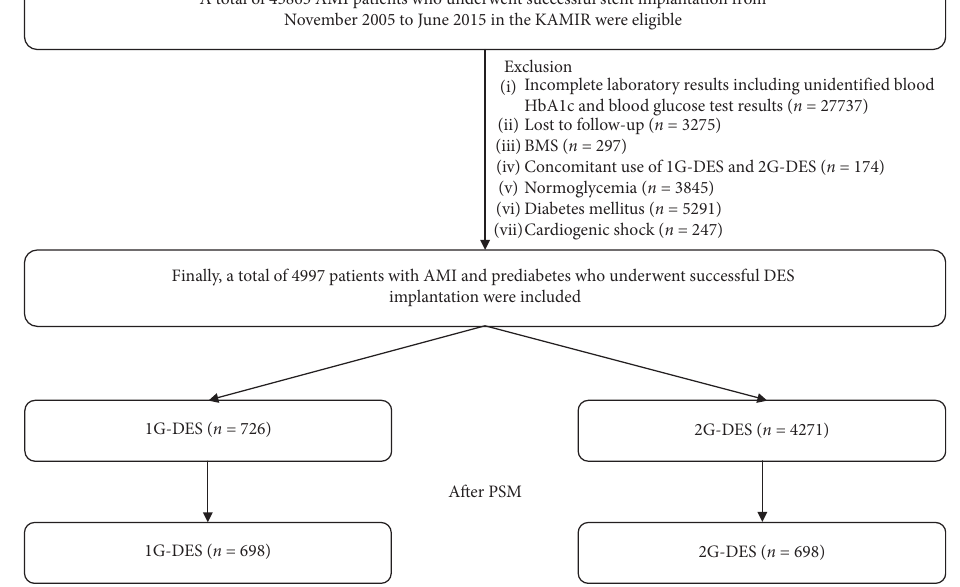
Figure 1: Study flowchart. AMI: acute myocardial infarction; KAMIR: Korea AMI Registry; HbA1c: hemoglobin A1c; BMS: bare-metal stent; 1G: first-generation; 2G: second-generation; DES: drug-eluting stent; PSM: propensity score-matching Table 1: Baseline clinical, laboratory, and procedural characteristics.